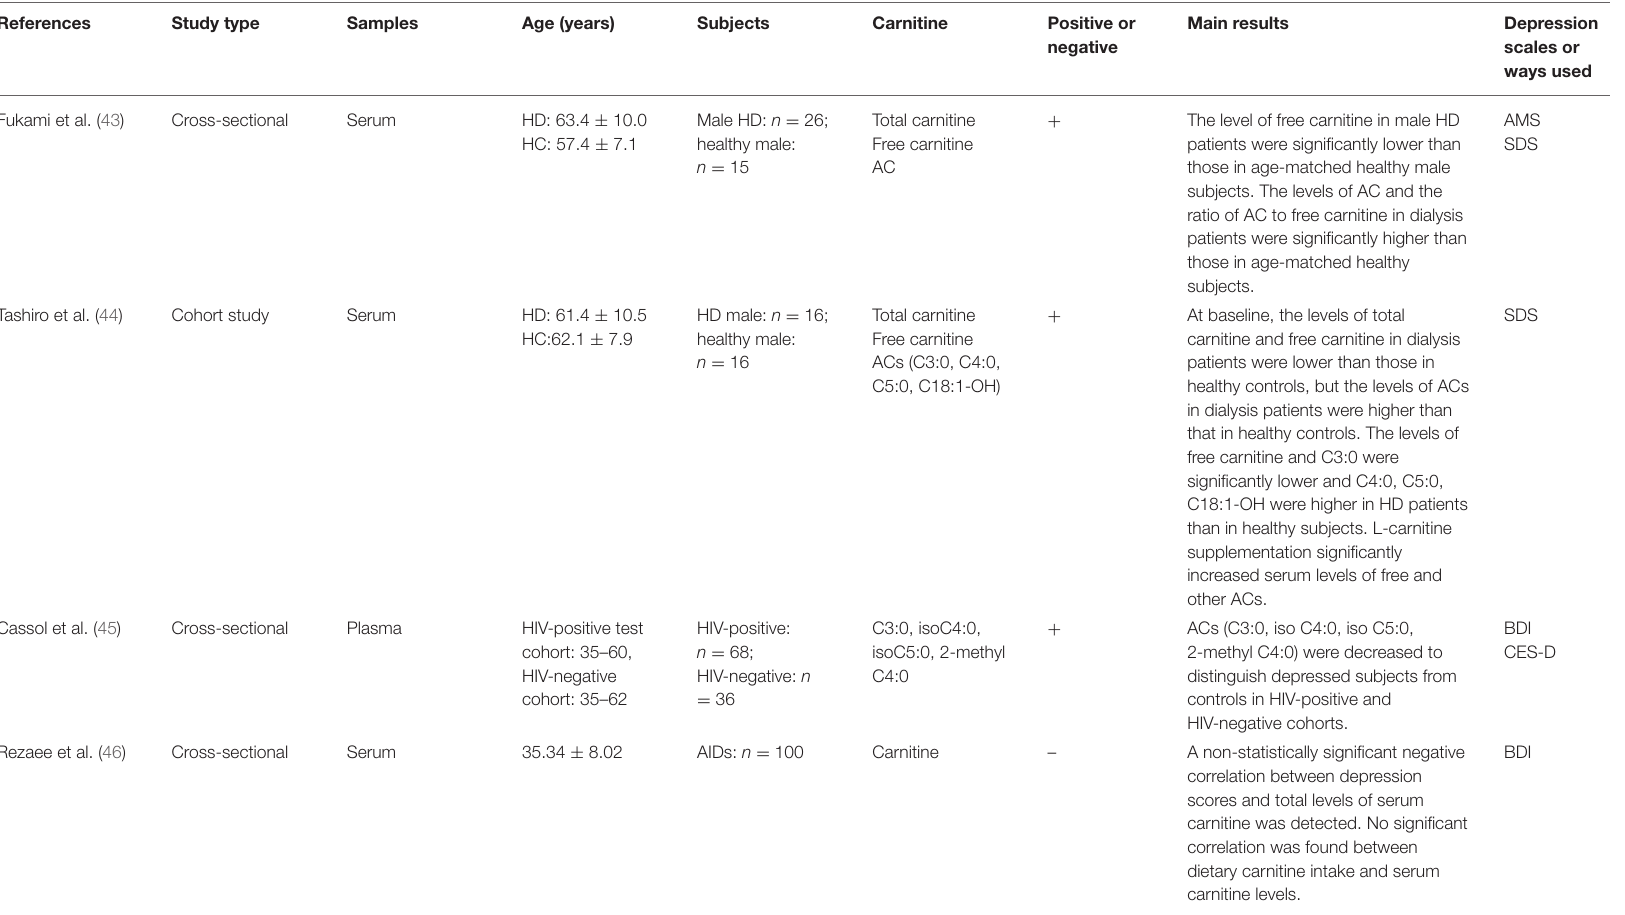
HIV-negative cohorts. – A non-statistically significant negative correlation between depression scores and total levels of serum carnitine was detected. No significant correlation was found between dietary carnitine intake and serum carnitine levels.